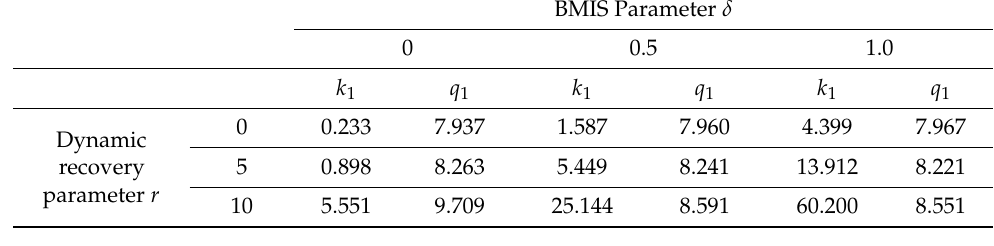
Table 1. Numerical values of parameters k 1 and q 1 involved in Equation (13).